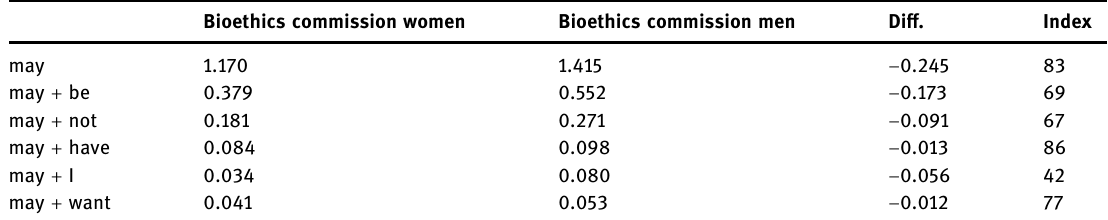
Table 28: Most frequent collocation with “ may, ” as per cent of total tokens ( normalised, n = 1,000